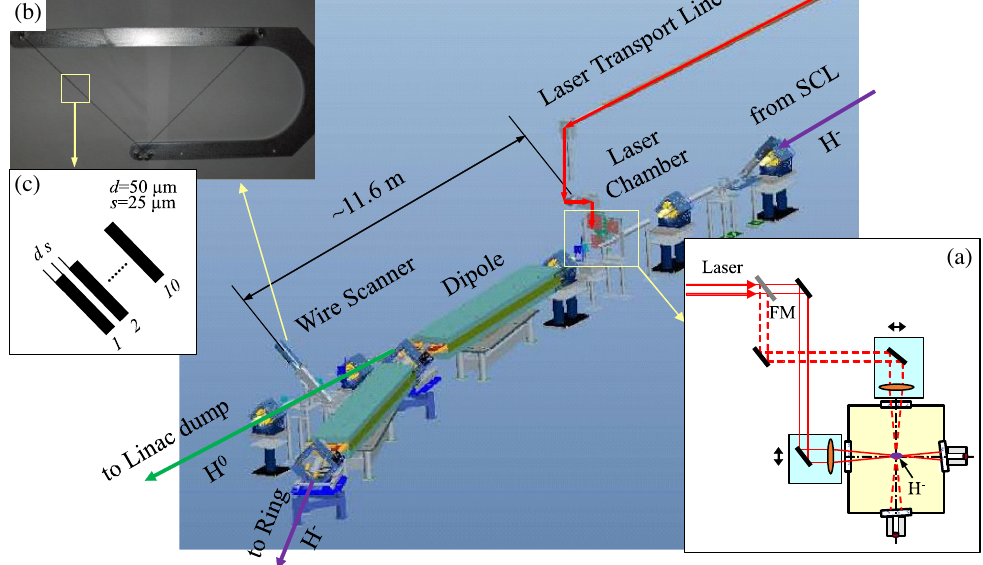
FIG. 7. Location of laser comb-based H − beam emittance measurement station in the SNS HEBT. Inset A shows the laser wire setup while insets B and C show the picture and dimension drawings of the ten-wire titanium wire scanner. FM: flipper mirror.